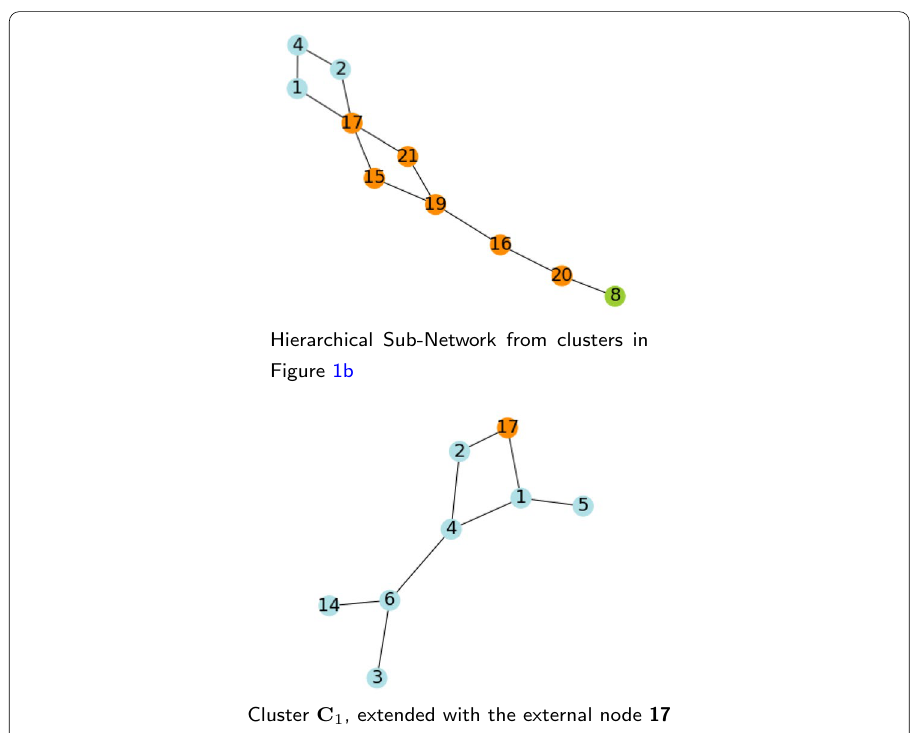
Cluster C 1 , extended with the external node 17 Fig. 3 Example of external node found through the